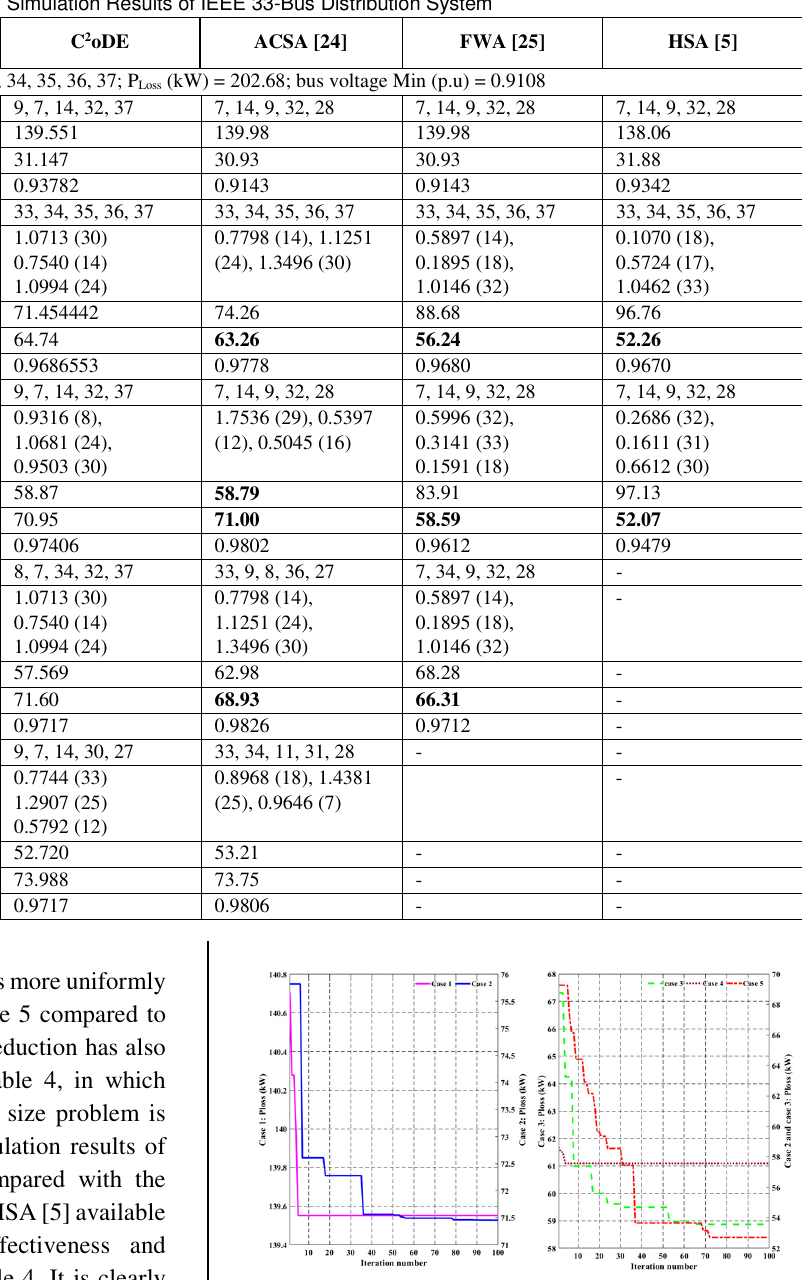
Fig. 8: Convergence Curve of Case 1 to Case 5 for IEEE 33-